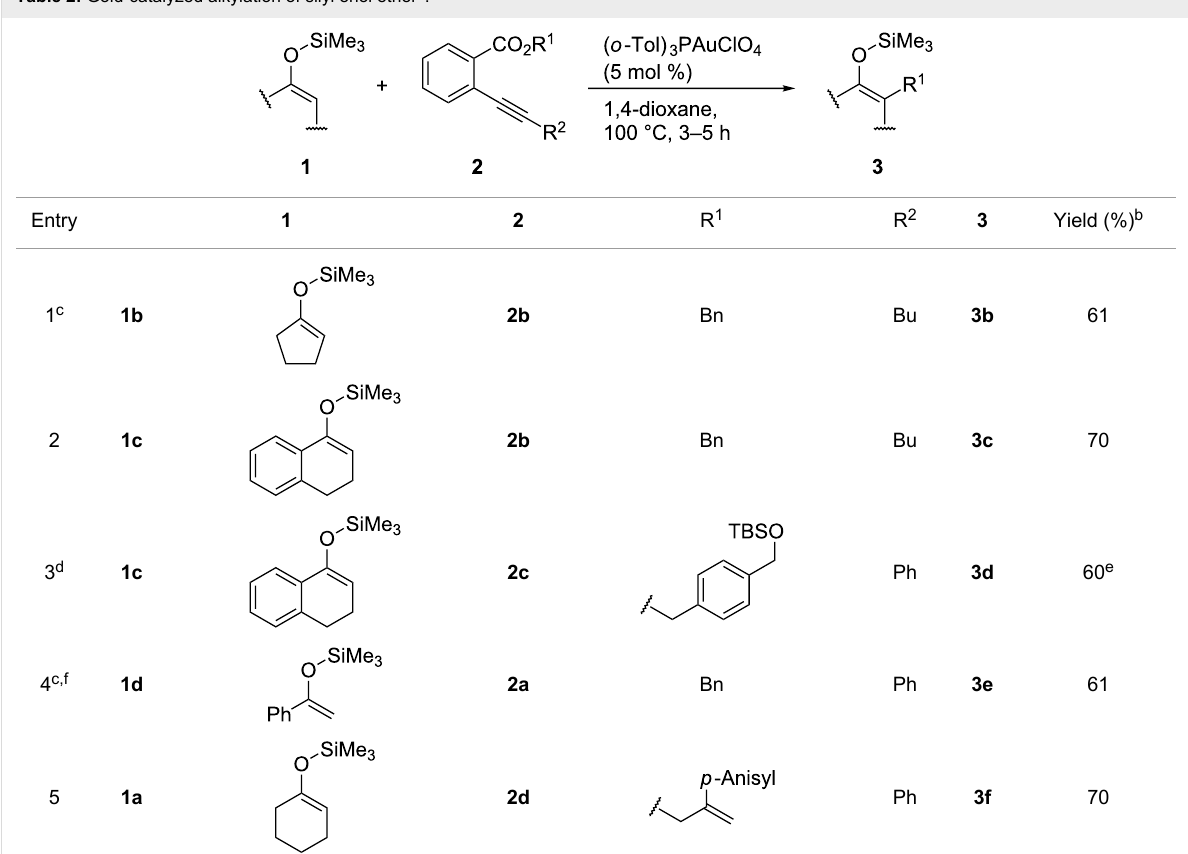
Table 2: Gold-catalyzed alkylation of silyl enol ether a .